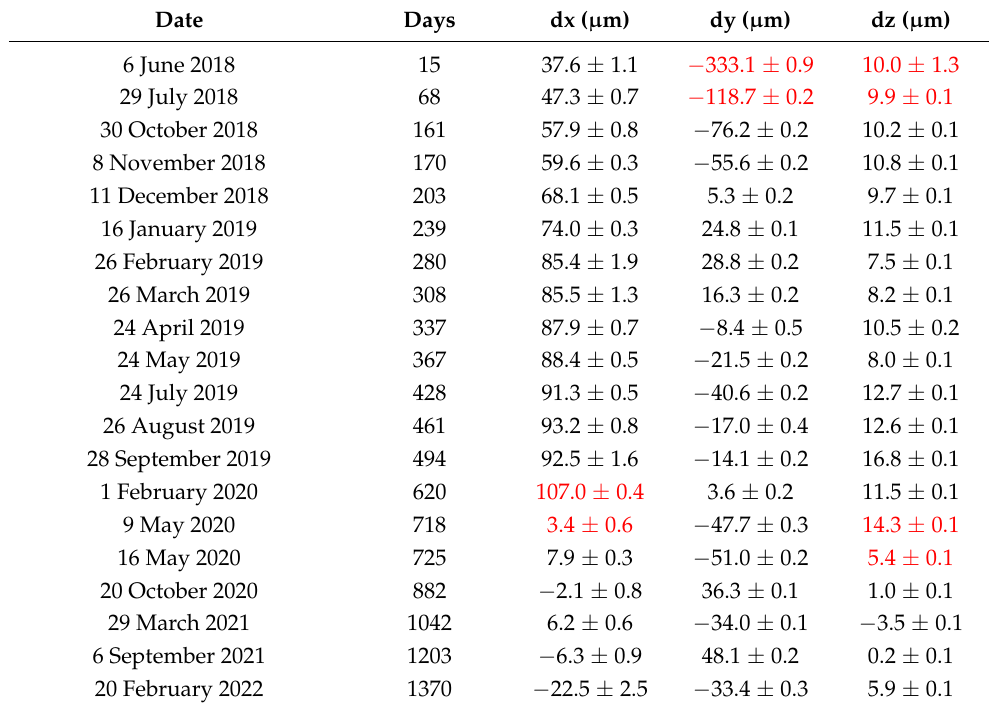
Table 9. Estimation of CM-offset of